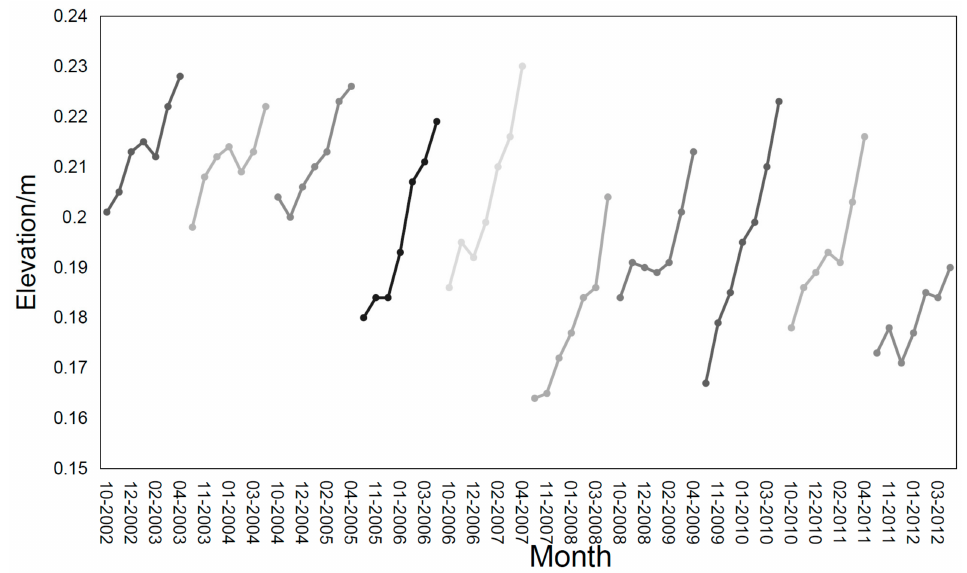
Figure 11. Monthly average sea ice freeboard variations in the Arctic Ocean from October 2002 to April